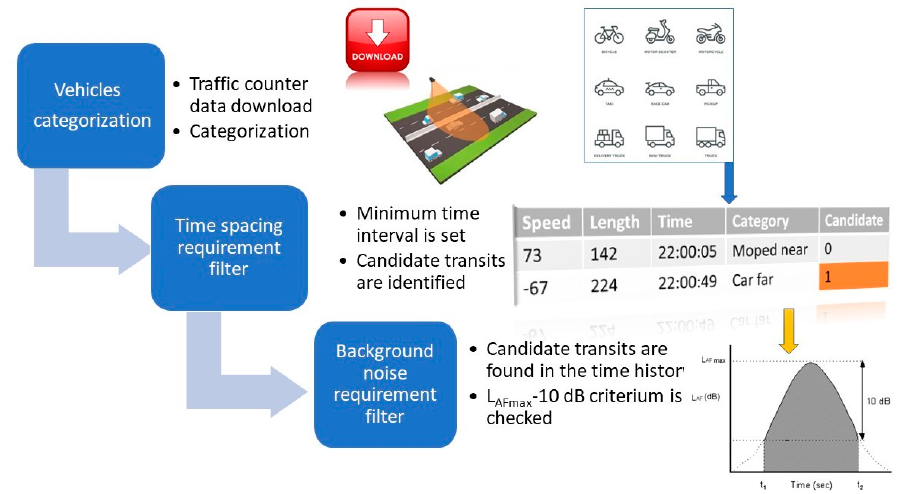
Figure 3. Features extraction phase: event selection process. The event extraction phase starts by collecting the average spectrum together with speed and direction and storing them in order to collect all the events. The average spectrum is then fitted according to Equation